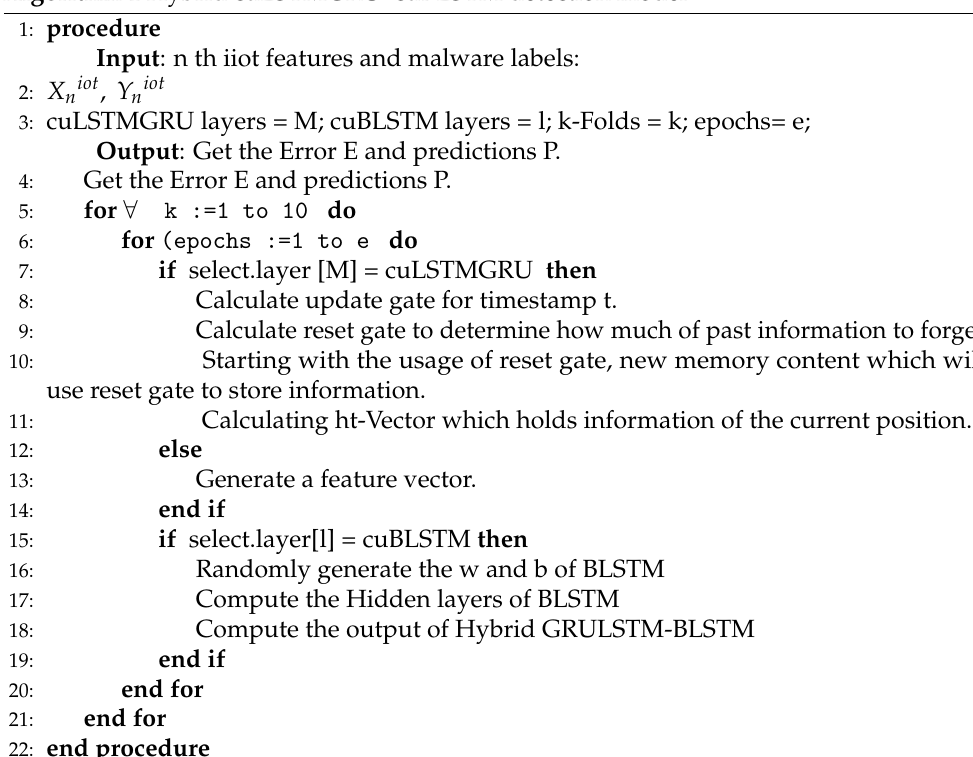
Algorithm 1 Hybrid cuLSTMGRU–cuBLSTM detection